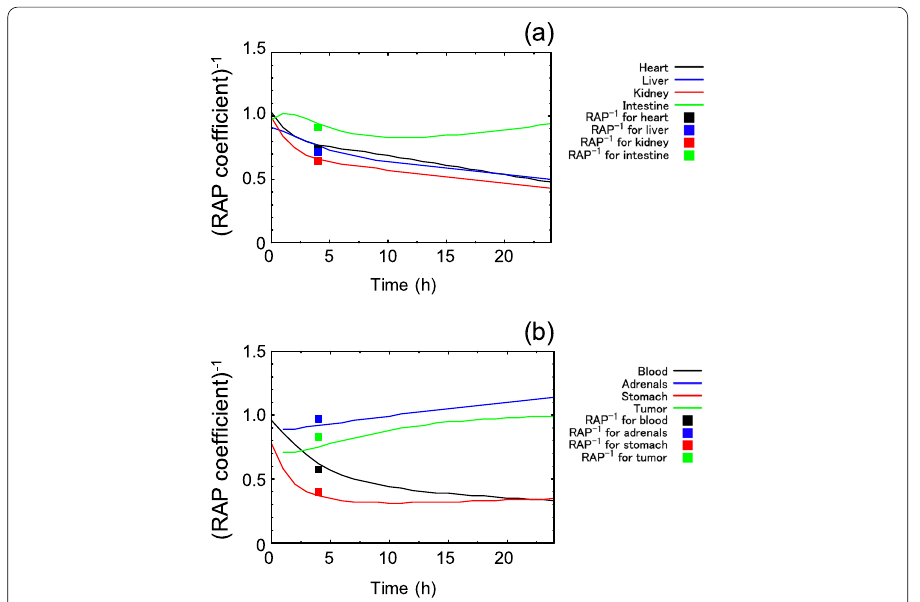
Fig. 2 Inverse of the RAP coefficient at t (solid line) and the representative RAP coefficient (square) on [ 131 I] MIBG [8]. a Heart, liver, kidney, and intestine. b Blood, adrenals and stomach, and tumor